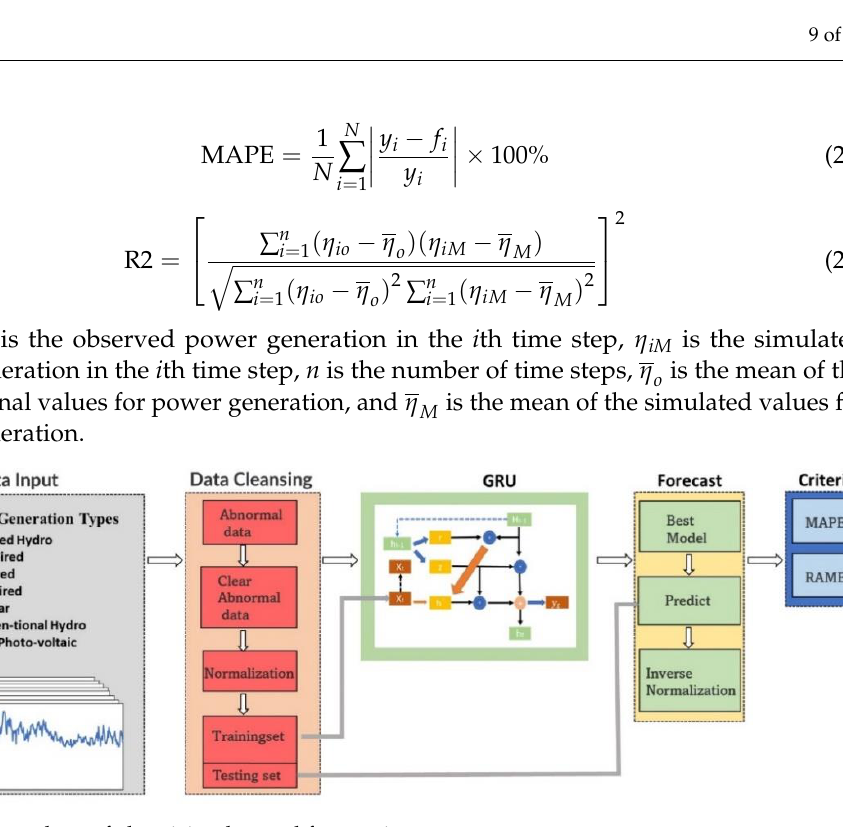
Figure 2. Flow chart of electricity demand forecasting.